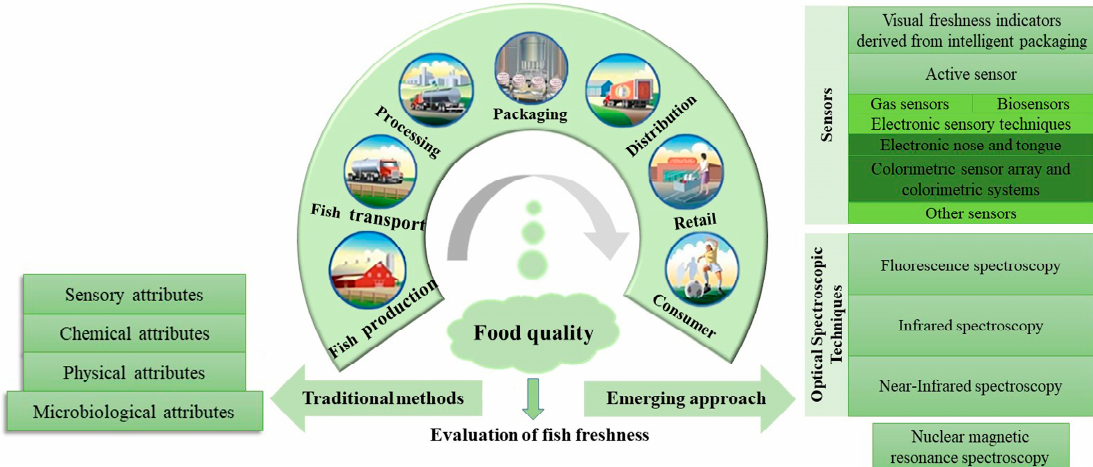
Figure 1. Graphical summary of the approach for fish freshness evaluation.